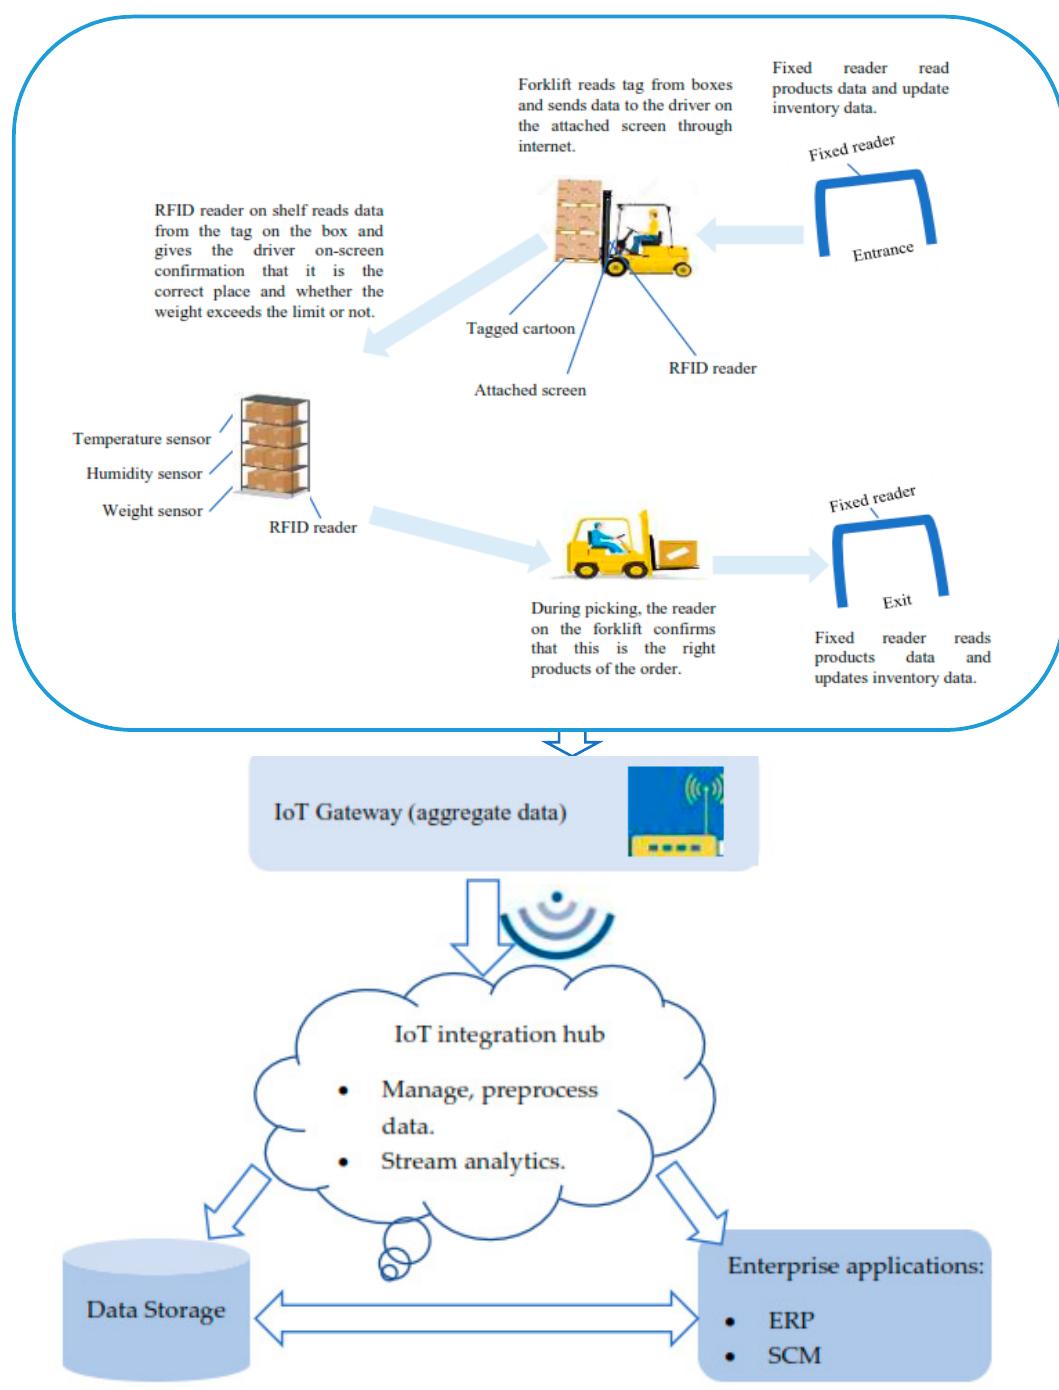
Figure 3. Proposed framework of implementing IoT in a warehouse.